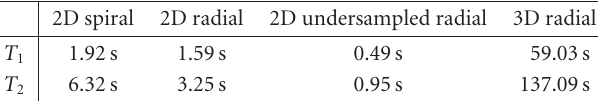
Table 2: Processing time comparison of reconstruction results with direct reconstruction ( T 1 ) and leakage reduction reconstruction ( T 2 ) on 2D and 3D